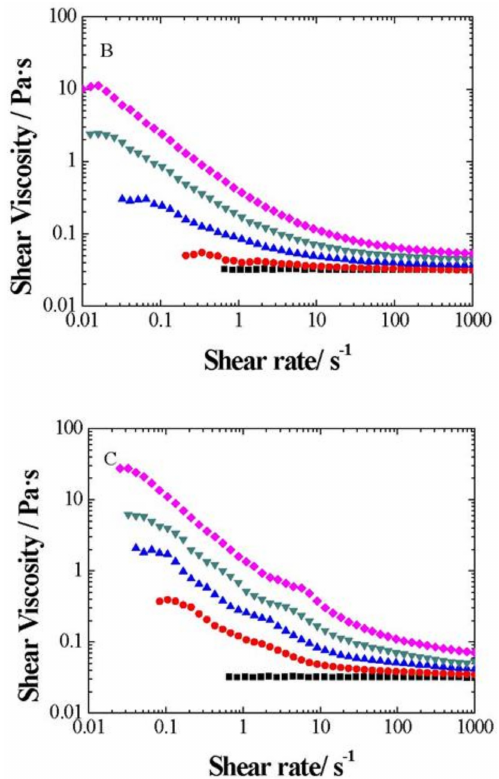
Figure 8. Shear viscosity change with shear rate ( γ ) for ( A ) xGnP/PG, ( B ) xGOnP/PG and ( C ) r-xGOnP/PG nanofluids, at 303.15 K for the concentrations: (cid:4) , PG; • 0.5 wt %, (cid:78) 1 wt %, (cid:72) 2 wt % and (cid:7) 3 wt